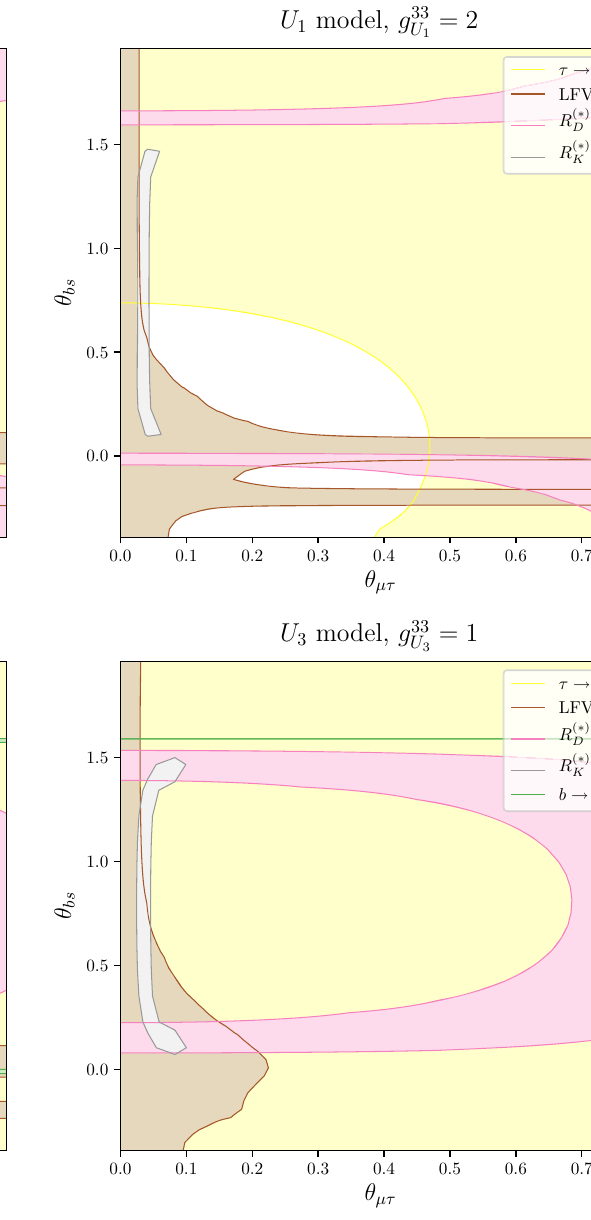
tively. The plots for S 3 and U 3 models correspond to g 33 The grey, magenta, brown, yellow and green regions in these figures show allowed parameter space for R K ( ∗ ) , R D ( ∗ ) , branching ratios of LFV decays ( τ → φμ & B → K τ ± μ ∓ ), branching ratio of τ → e ν ¯ ν and branching ratios of B → K ( ∗ ) ν ¯ ν transitions,